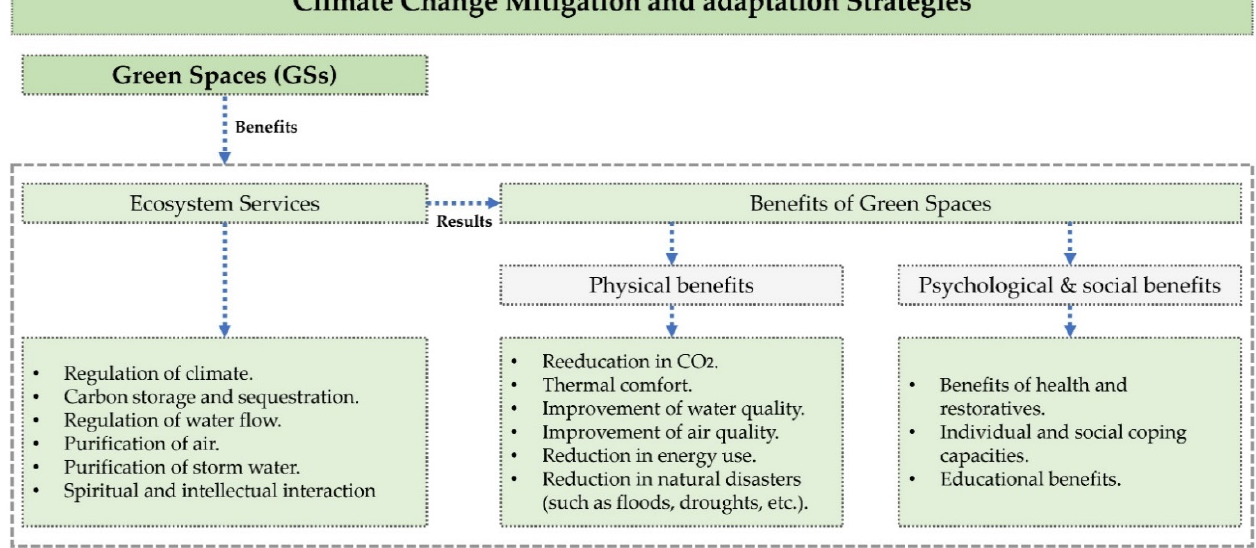
Figure 8. Benefit of GSs within climate change mitigations and adaptations the framework.